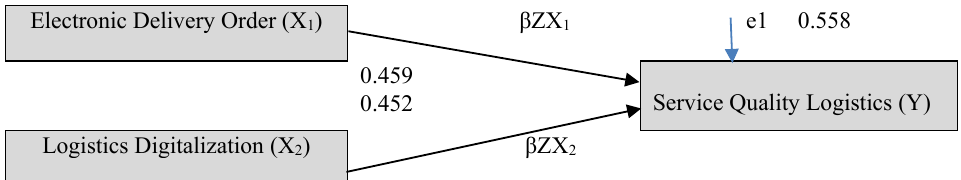
Fig. 2. Sub-Structural Correlation of X 1 , X 2 to